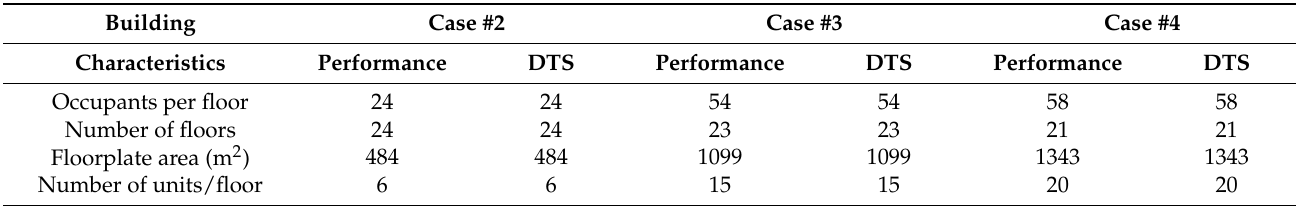
Table 2. Characteristics of the building case